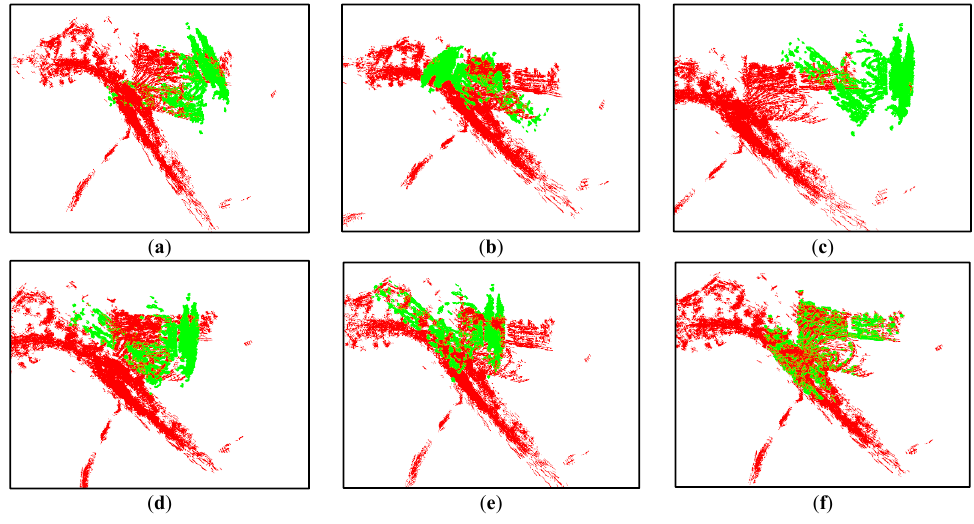
Figure 6. Local minima of the triangular area test: ( a – e ) show five local minimum registrations in the triangle area test; ( f ) shows the desired registration result.